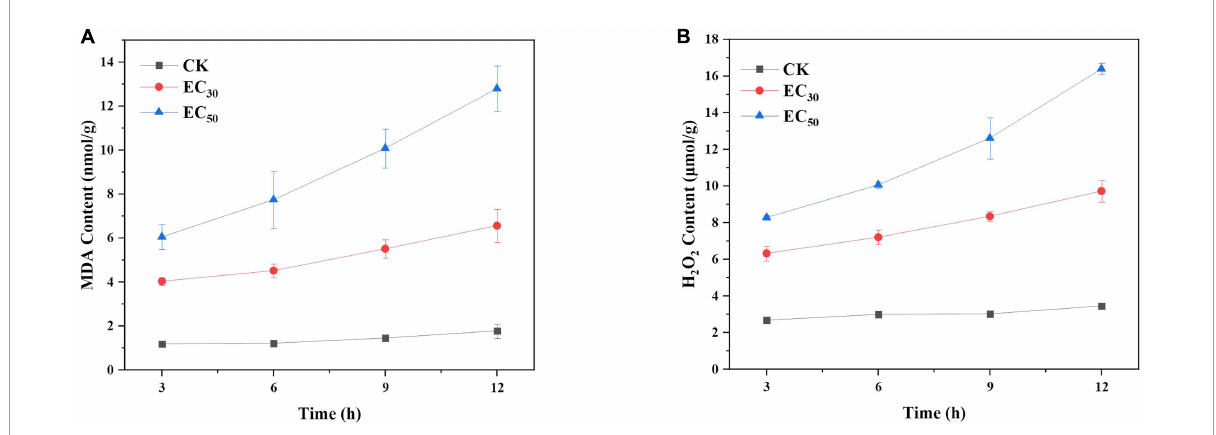
FIGURE5 Effects of JEO on MDA content (A) and H 2 O 2 content (B) from B. cinerea mycelia during 12 h of incubation. The mycelia were treated with different concentrations of JEO (0 as control, EC 30 , and EC 50 ). The bars represent the standard error of the mean ( n = 3). JEO, juniper essential oil; MDA, malondialdehyde.